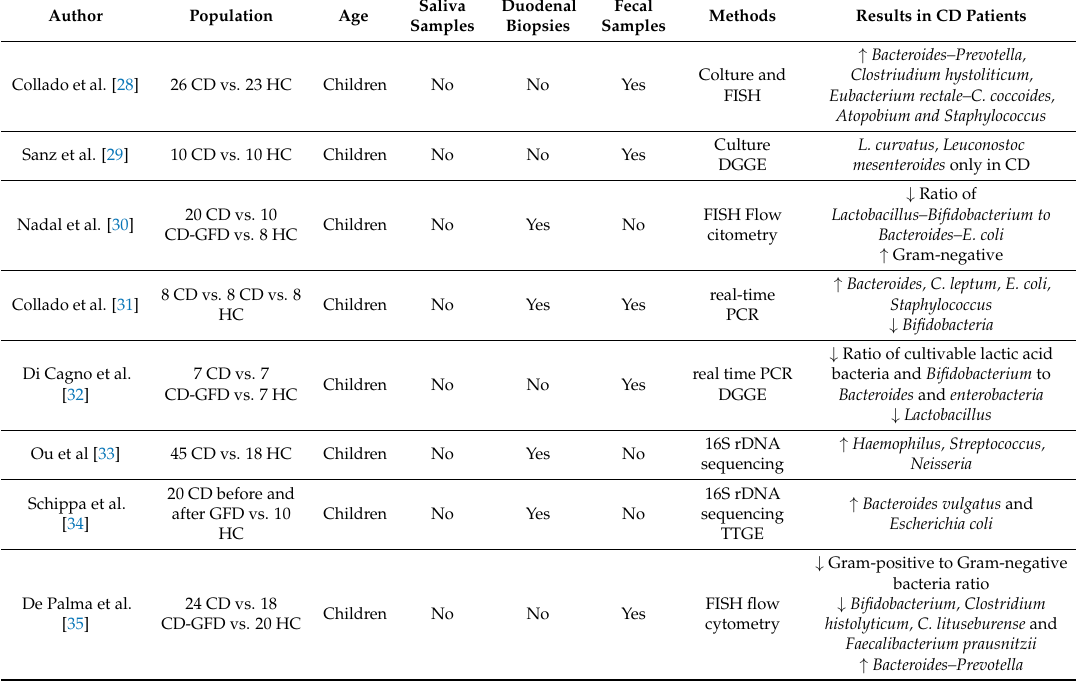
Table 1. Scientific findings of the last 10 years on salivary, duodenal, and fecal microbiota in celiac